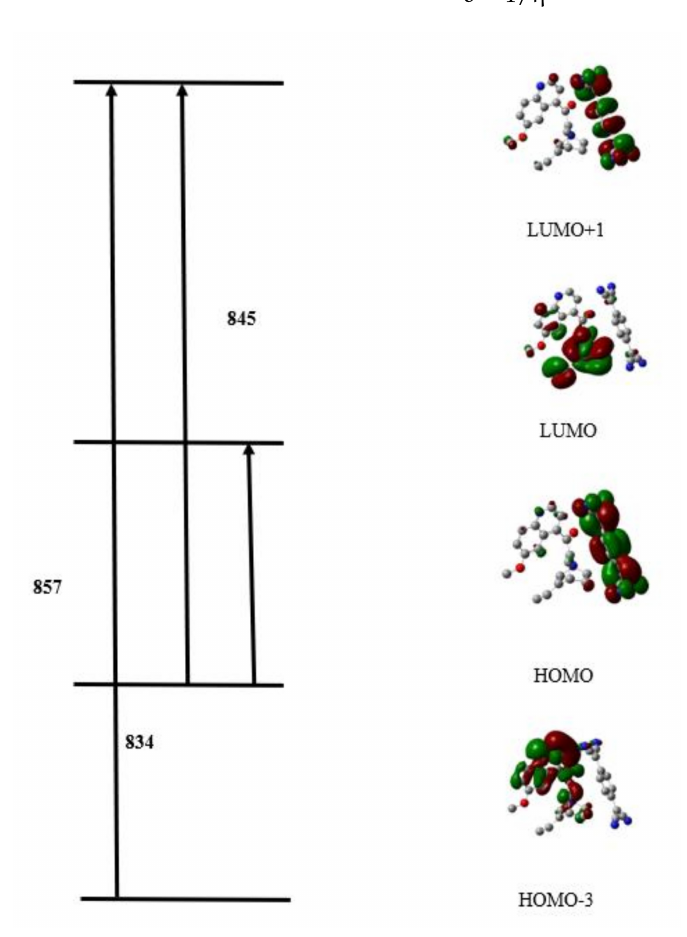
Figure 11. Assignments of theoretical electronic absorption transitions of Quinine → TNCQ charge transfer